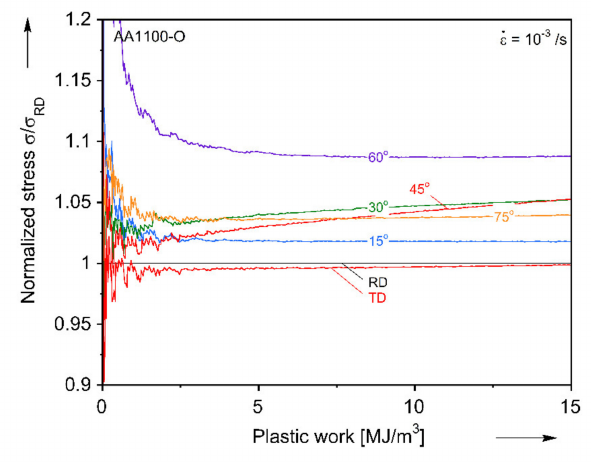
Figure A1. Evolution of normalized stress with plastic